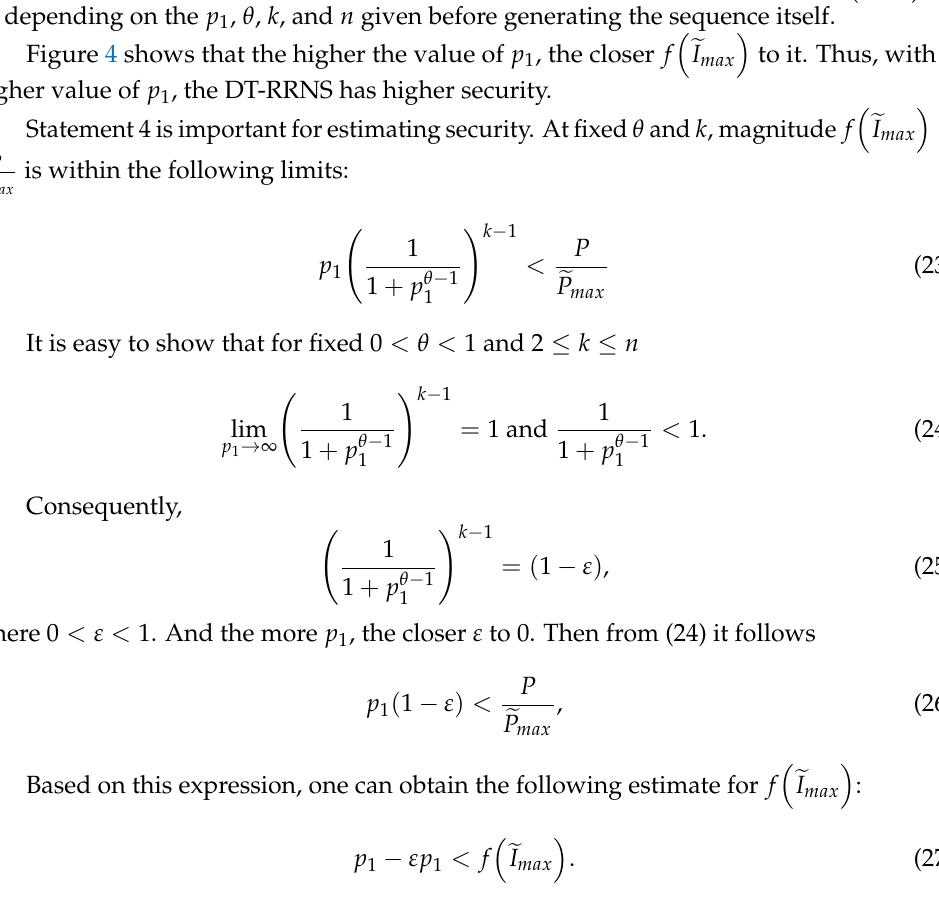
𝑓(𝐼̃ 𝑚𝑎𝑥 ) varying 𝑝 1 for 𝜃 = 0.477 , 𝑛 = 15 , and 𝑘 = 7 . Figure 4. R = f ( (cid:101) I max ) varying p 1 for θ = 0.477, n = 15, and k = 𝑝 1 p 1